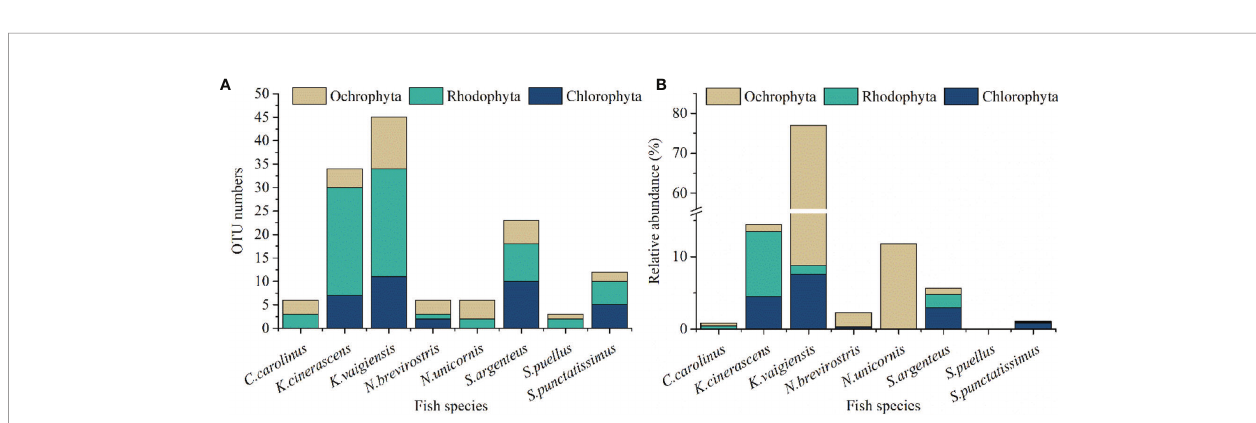
FIGURE 1 | Relative abundances of eukaryote sequences found in fi sh intestines, determined with 18S rRNA high-throughput sequencing. (A) phylum level. Polylines show the sum of the relative abundance of the phyla Streptophyta, Chlorophyta, Ochrophyta and Rhodophyta. (B) class level.